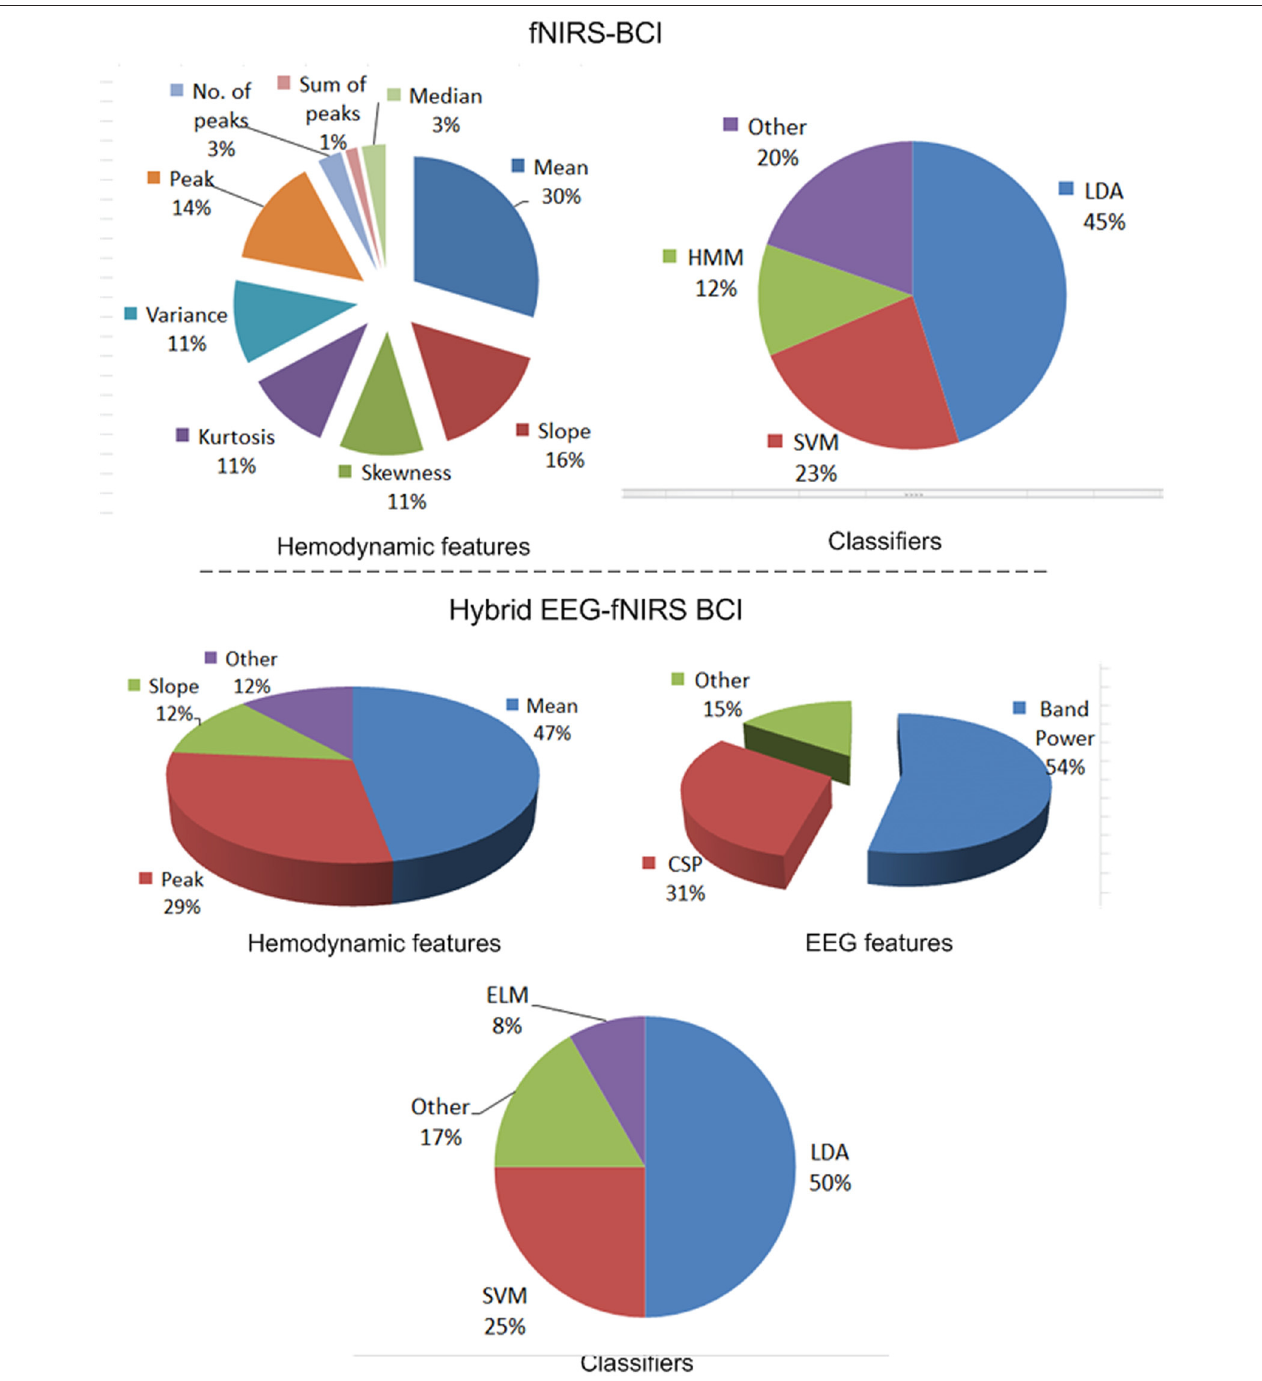
FIGURE 8 | Features and classifiers used in fNIRS and hybrid EEG-fNIRS studies (64 fNIRS-BCI papers and 14 hybrid EEG-fNIRS papers from 2010 to